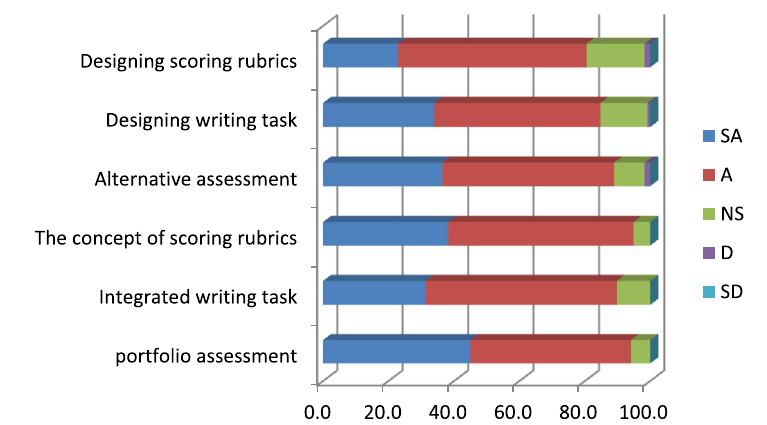
Fig. 1 Teachers’ knowledge of basic concepts in classroom writing assessment (the bars represent